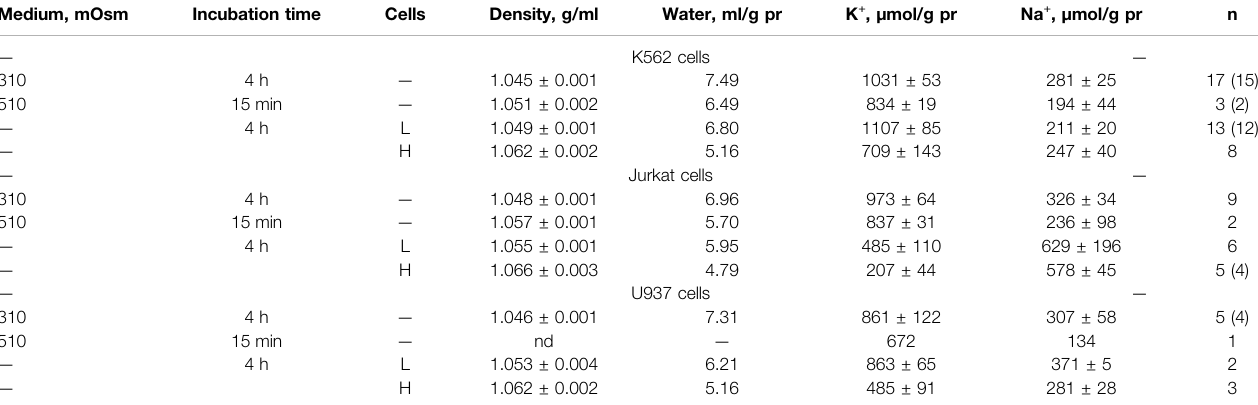
TABLE 6 | Changes in the buoyant density, K + and Na + content in living K562, Jurkat, and U937 cells transferred to a hyperosmolar medium with adding 200 mM sucrose. Medium,